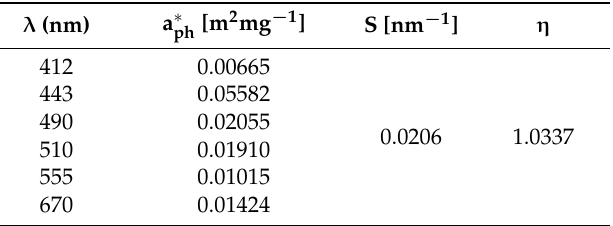
The set of fixed parameters at various wavelengths used by GSM as updated by Maritorena et al. [29]. From left to right: the chl-a specific phytoplankton absorption coefficients (aph*( λ )), the Colored Detrital Matter (CDM) light absorption values (S) and the spectral slopes of particle backscattering ( η